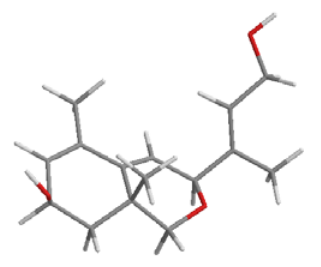
Figure 4. Conformation of apocarotenoid 2 .